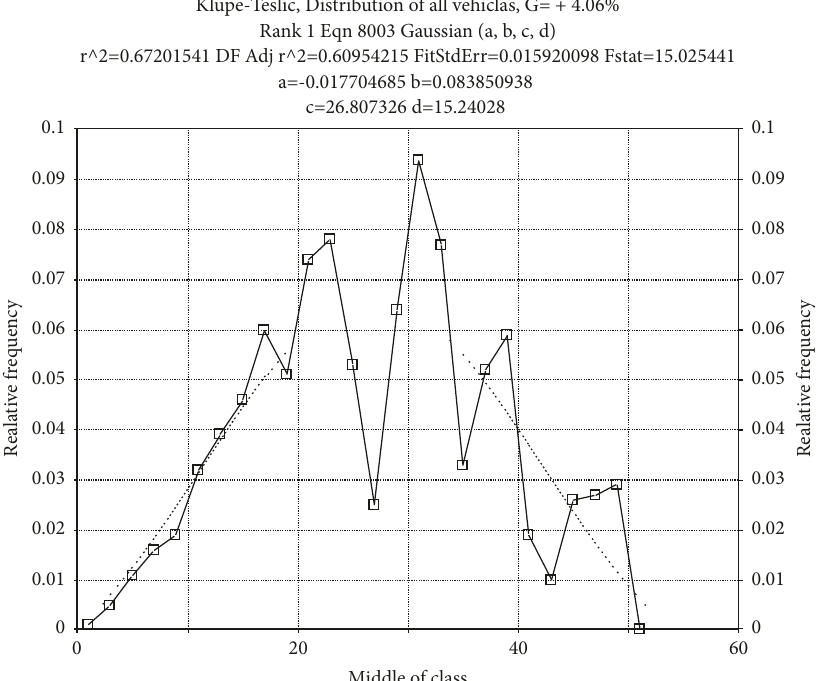
Figure 2: Example of relative frequency of obtained values of speed deviation from the speed limit for all vehicles in traffic